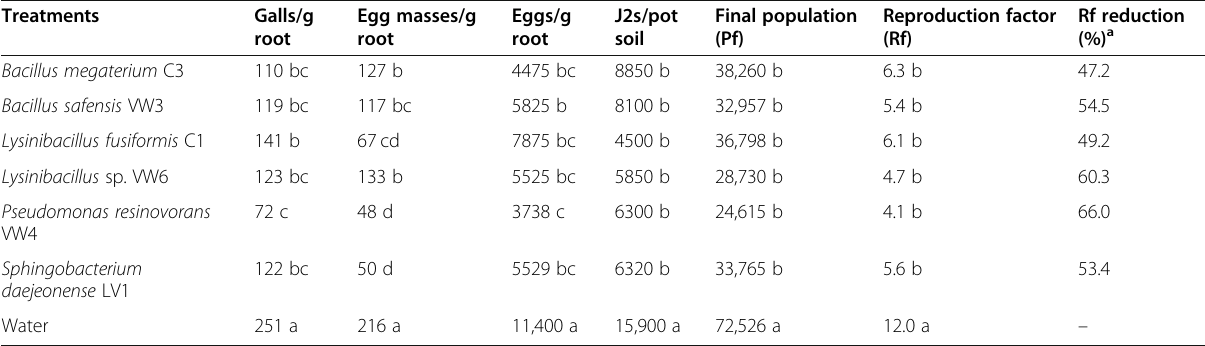
Table 3 Effects of six selected bacterial isolates on nematode indices of Meloidogyne javanica on tomato roots in a glasshouse Treatments